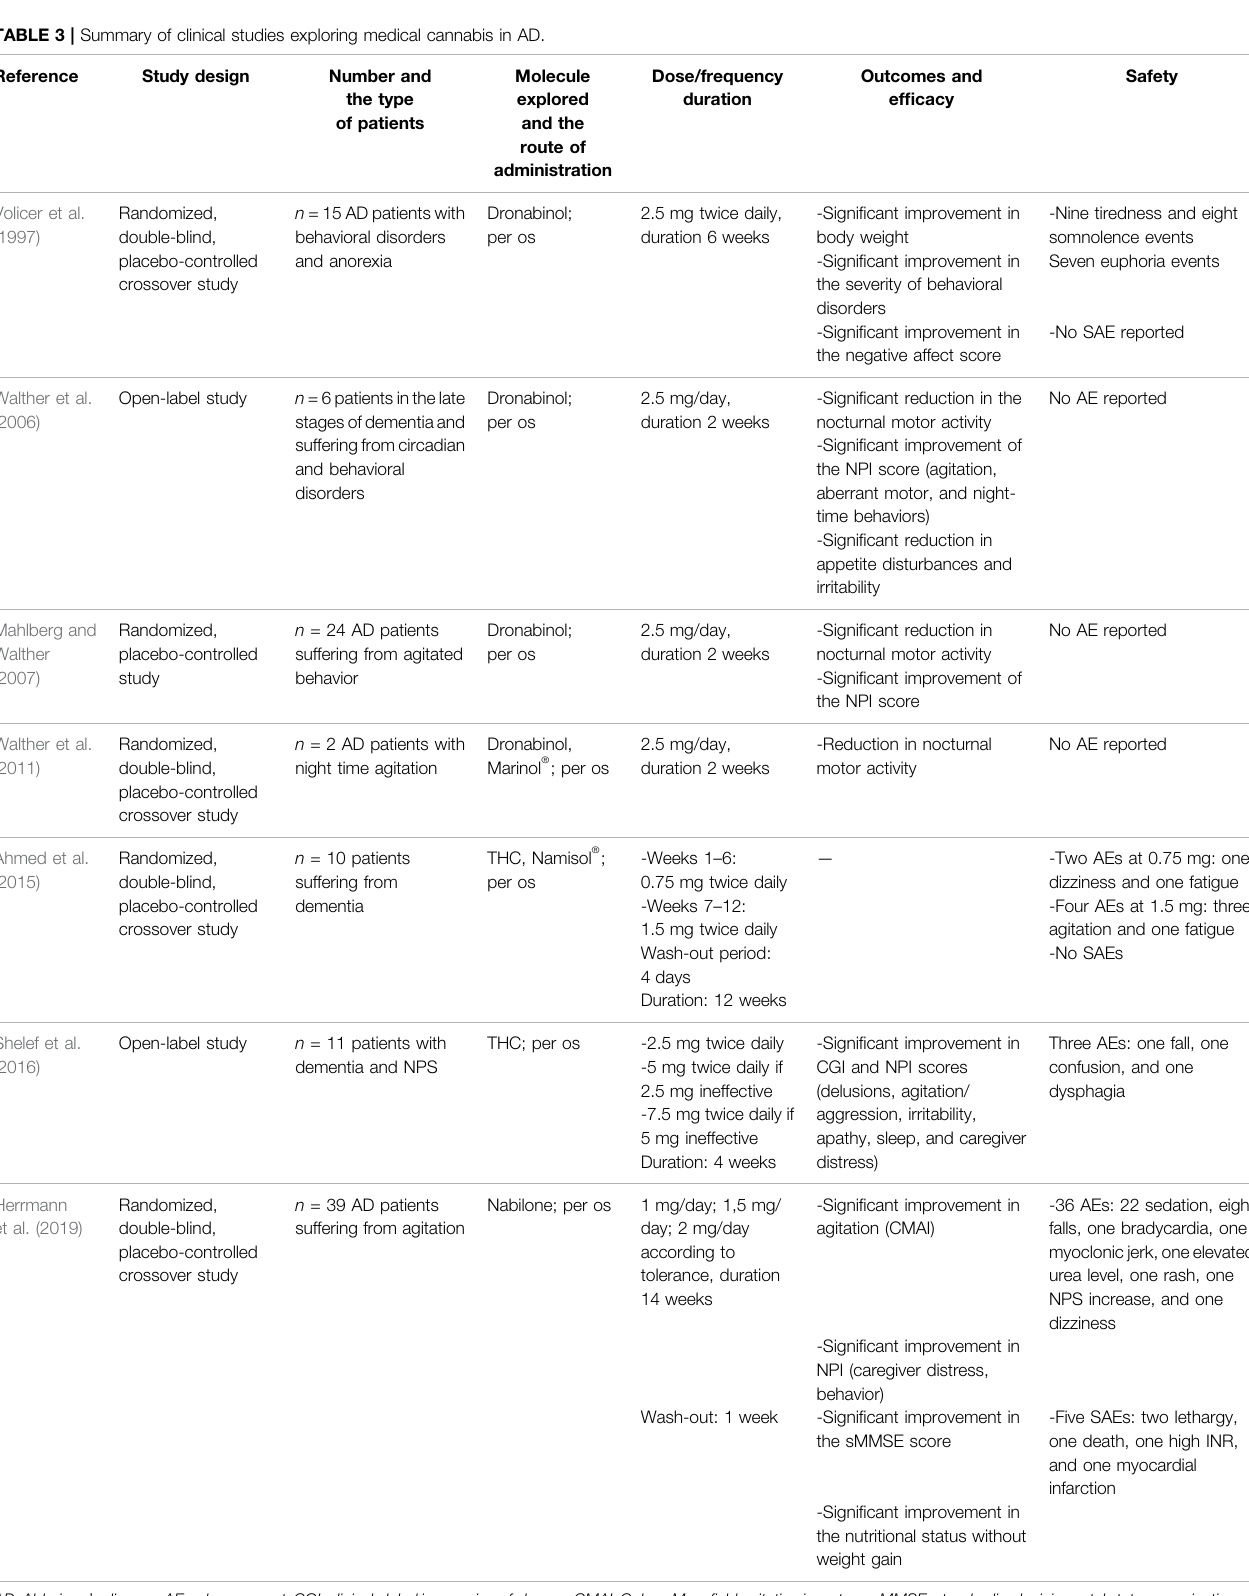
TABLE 3 | Summary of clinical studies exploring medical cannabis in AD.